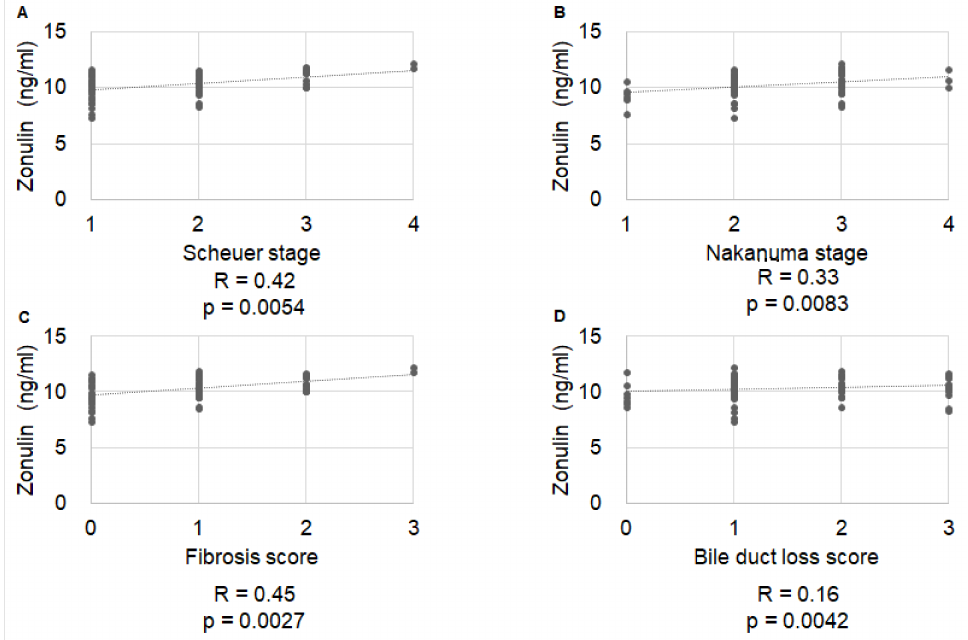
Figure 3. Correlation of serum zonulin levels with histological stage. ( A ) Scheuer stage, R = 0.42, p = 0.0054; ( B ) Nakanuma stage, R = 0.33, p = 0.0083; ( C ) Nakanuma fibrosis score, R = 0.45, p = 0.0027; ( D ) Nakanuma bile duct score, R = 0.16, p =